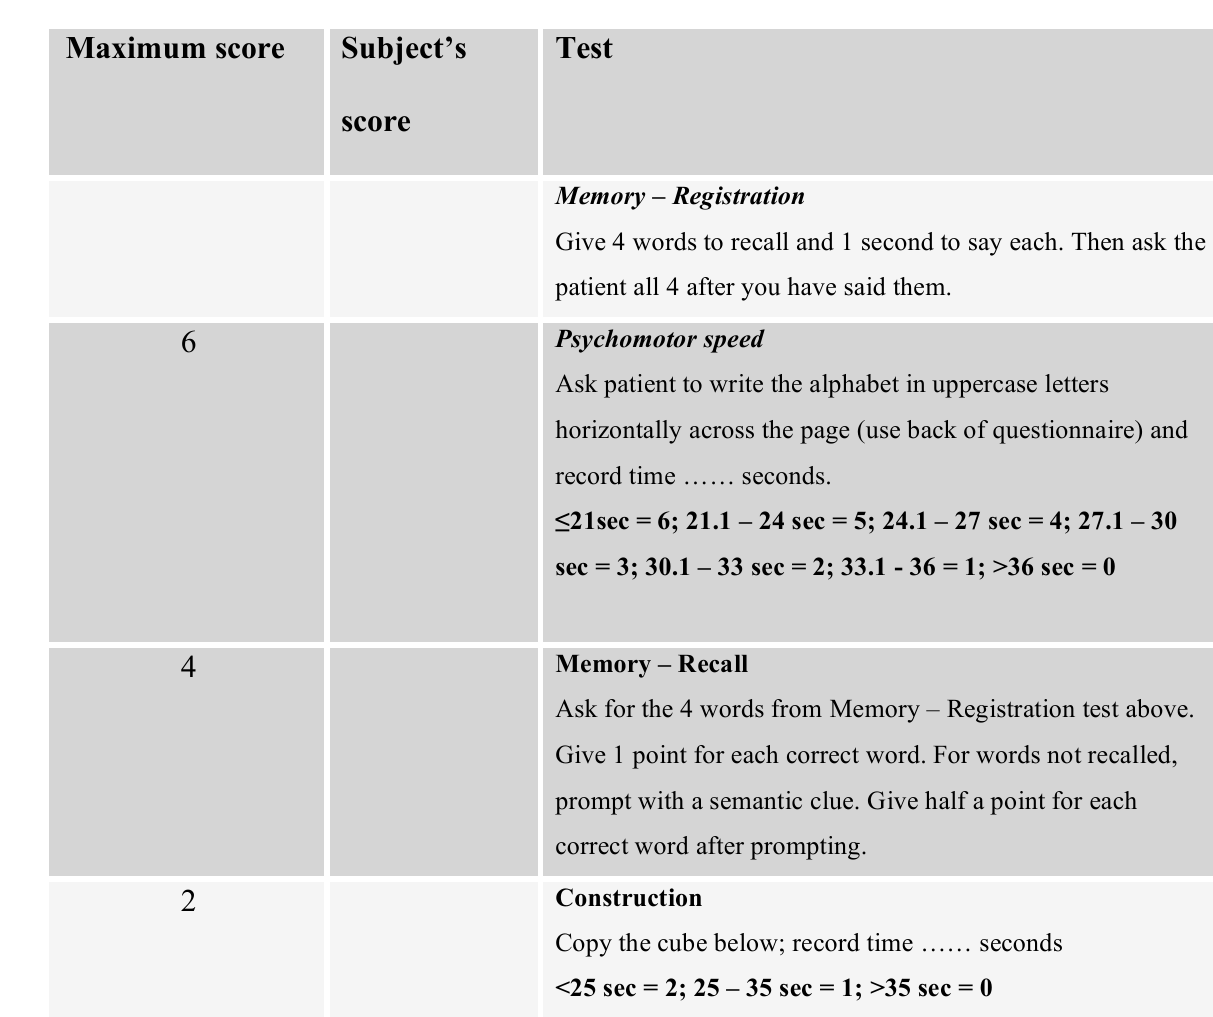
Fig. 1. Modified HIV Dementia Scale